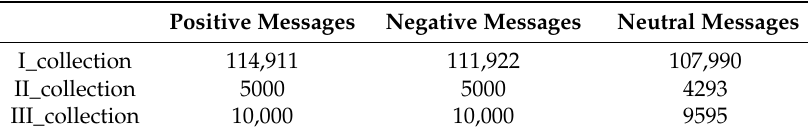
Table 1. Distribution of texts in the collections by sentiment